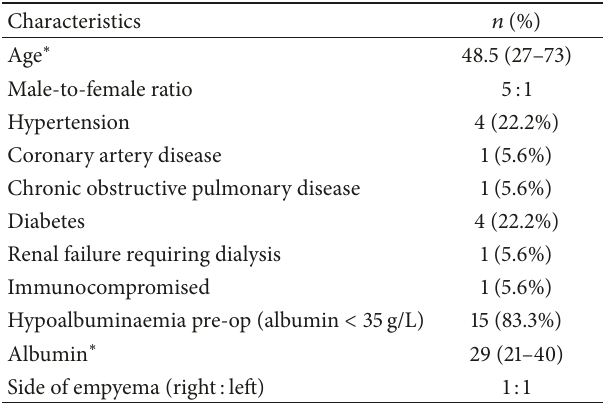
Table 1: Patient characteristics. Table 2: Patient